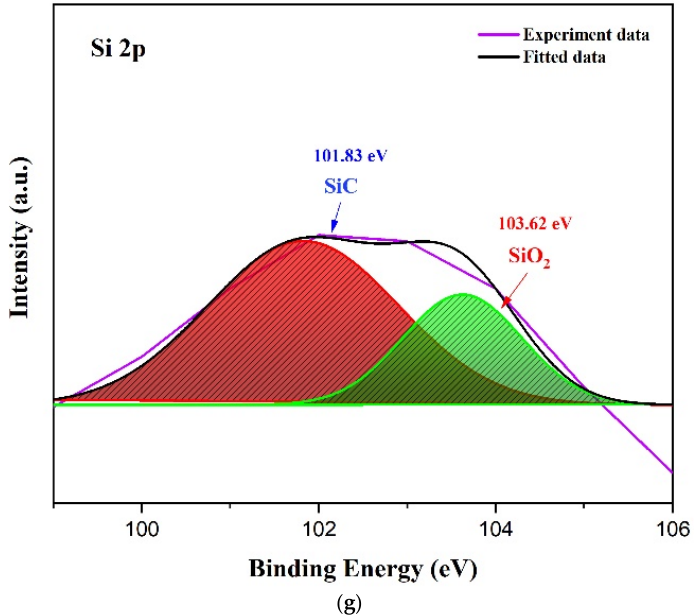
Figure 6. XPS spectra of the sensing material 1% Pd-5% Au/MWCNT; ( a ) survey spectrum, ( b ) C 1s, ( c ) O 1s, ( d ) Au 4f, ( e ) Pd 3d, ( f ) Mo 3d, ( g ) Si 2p.